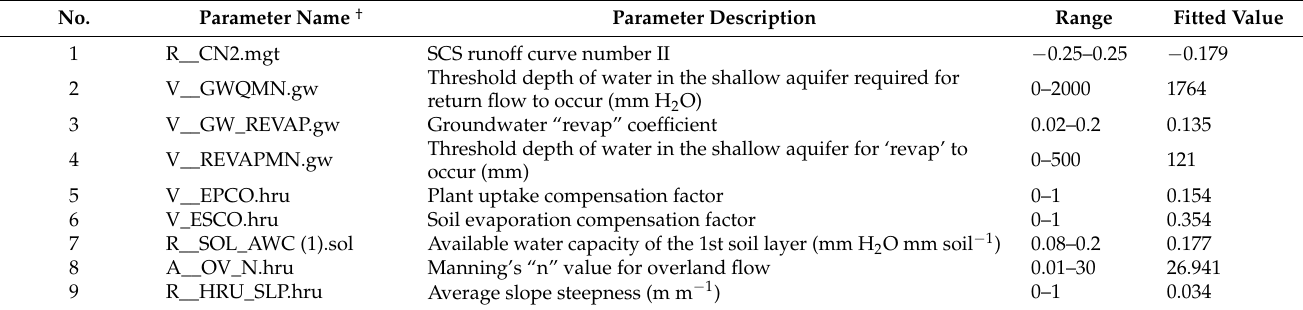
Table 2. The sensitive parameters range and their fitted values in